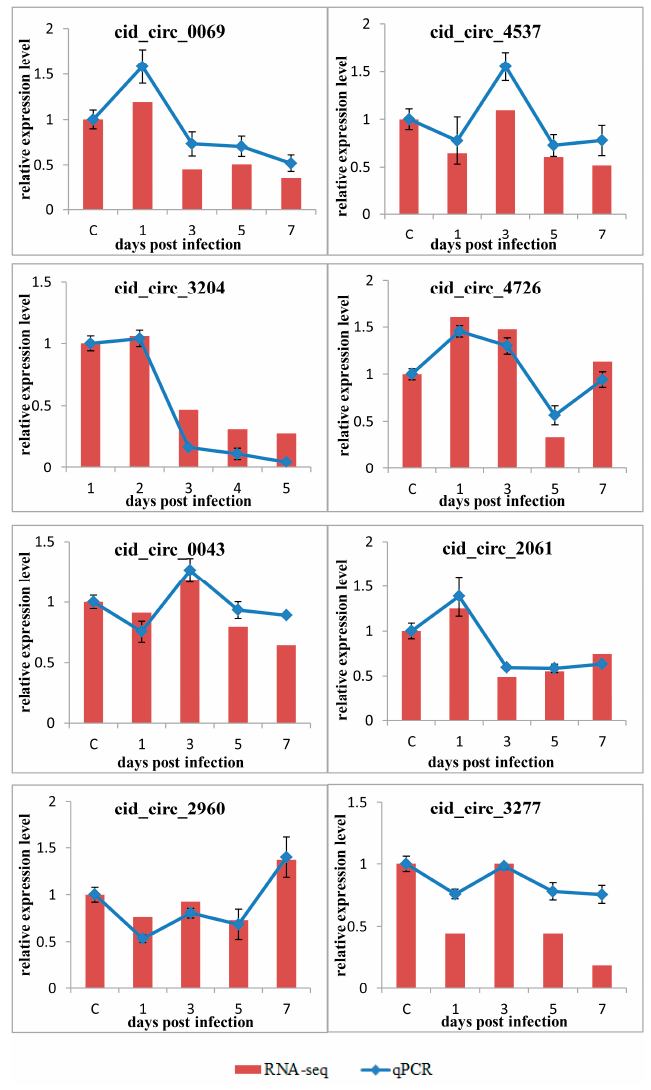
Figure 8. Verification of circRNA expression level by RT-qPCR. Eight circRNAs were randomly selected for RT-qPCR analysis and compared with data obtained using RNA-sequencing (RNA-seq). The relative expression level of circRNAs at different time points were calculated as the ratio of the gene expression level (qPCR) or normalized transcripts per million (TPM) (RNA-seq) relative to that at 0 dpi (controls). The RT-qPCR data are given as means ± standard deviation of three replicates.